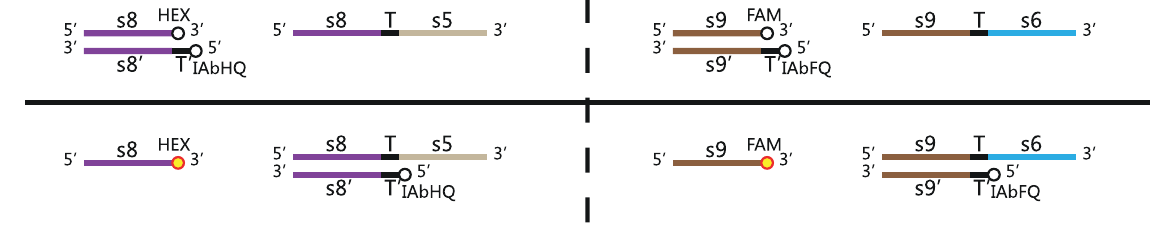
Figure 4. HEX and FAM fluorescent probes to detect the output spike ‘‘1/0’’ of DNA Neuron.